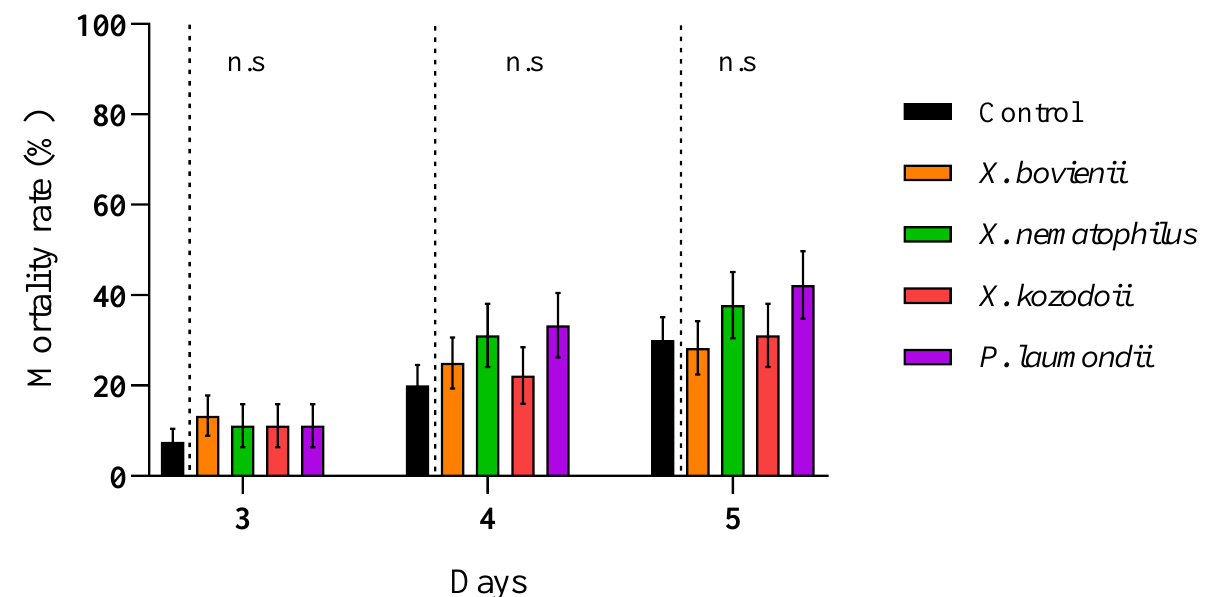
for each single application).